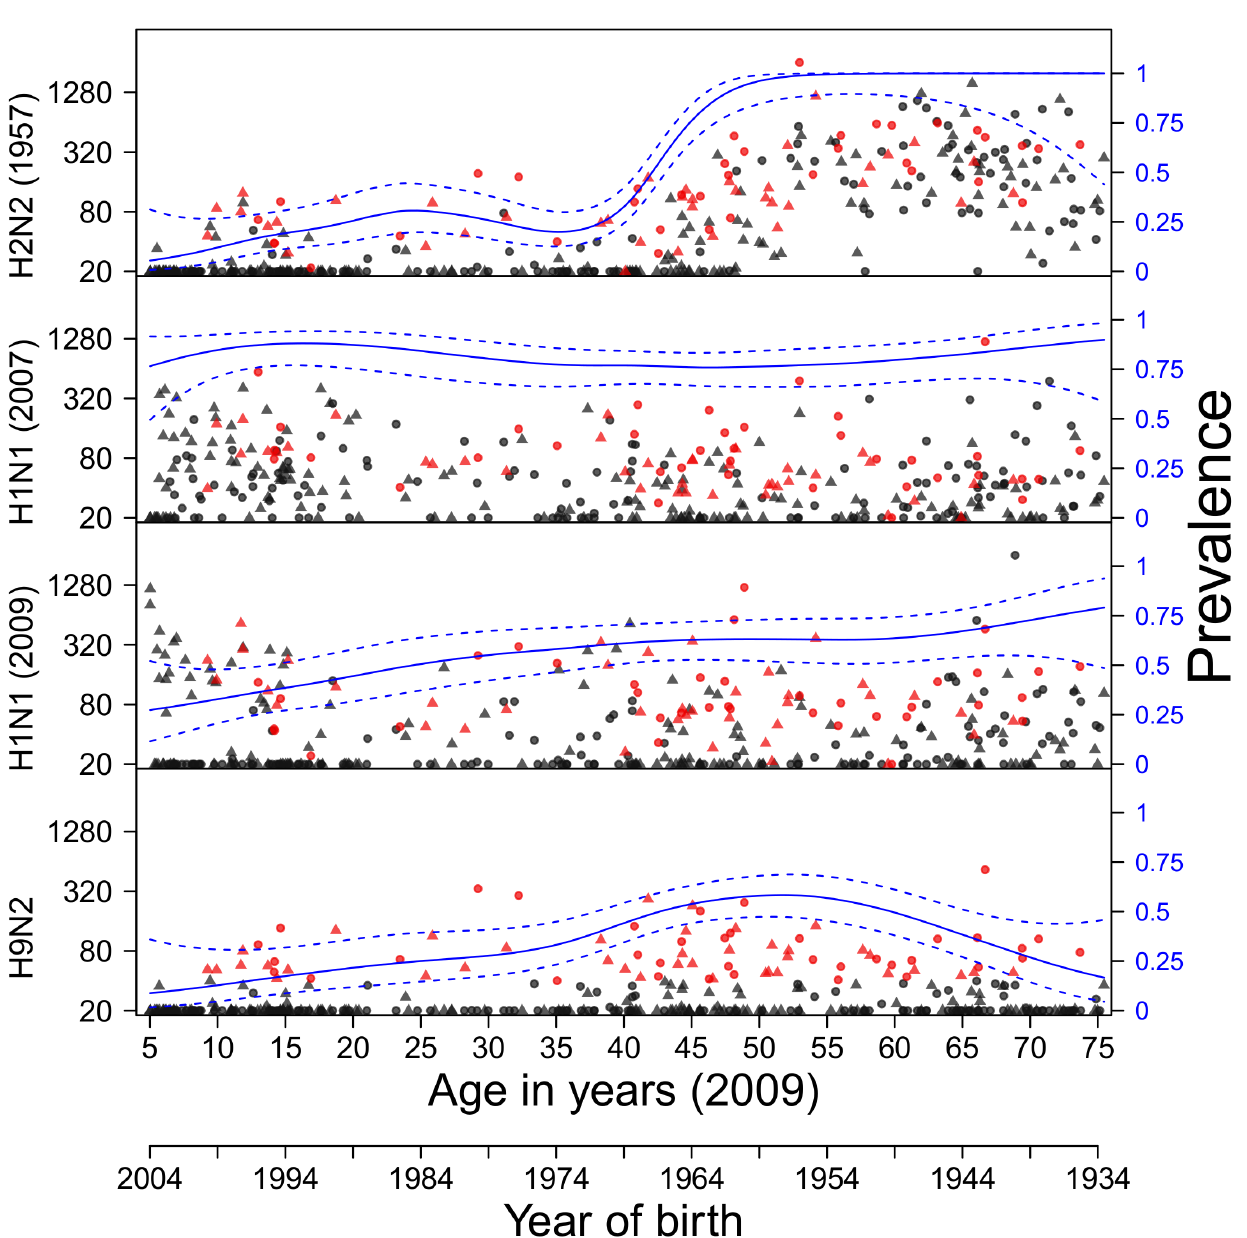
Fig 1. Age-specific antibody titers to group 1 influenza A viruses. Pre- and post-pandemic samples are representedby trianglesand circles, respectively.Red dots indicatethat H9N2titer was (cid:21) 40. Solid and dotted lines show weightedseroprevalence estimates and associated95% confidenceranges, estimated with a logistic generalized additive model (right axis). Seroprevalence estimates are weightedby their contributionto the populationcensus [8, 43]. For clarity, only pooledpre- and post-pandemic prevalence estimates are presented. Antigens (HA1) includedare from viruses A/South Carolina/1/1918 (H1N1), A/Canada/720/2005 (H2N2) (1957-likeH2N2), A/Brisbane/59/2007 (H1N1), A/California/6/2009 (H1N1), A/Guinea fowl/HongKong/WF/10/1999(H9N2).